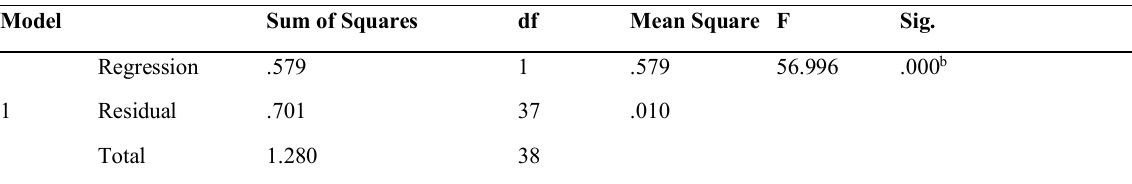
Table 3: ANOVA for stakeholder involvement and tourism performance